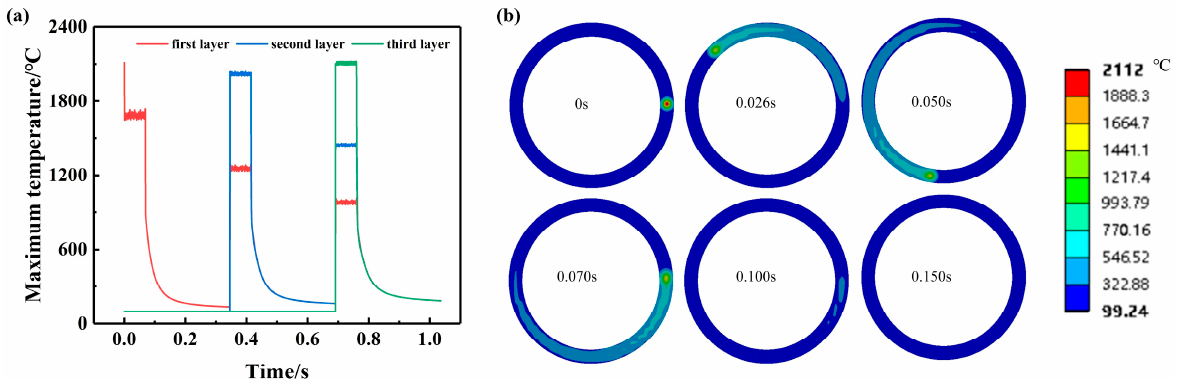
Figure 5. ( a ) Maximum temperature curve of ring scanning, ( b ) temperature field distribution of the first layer of the ring scanning.